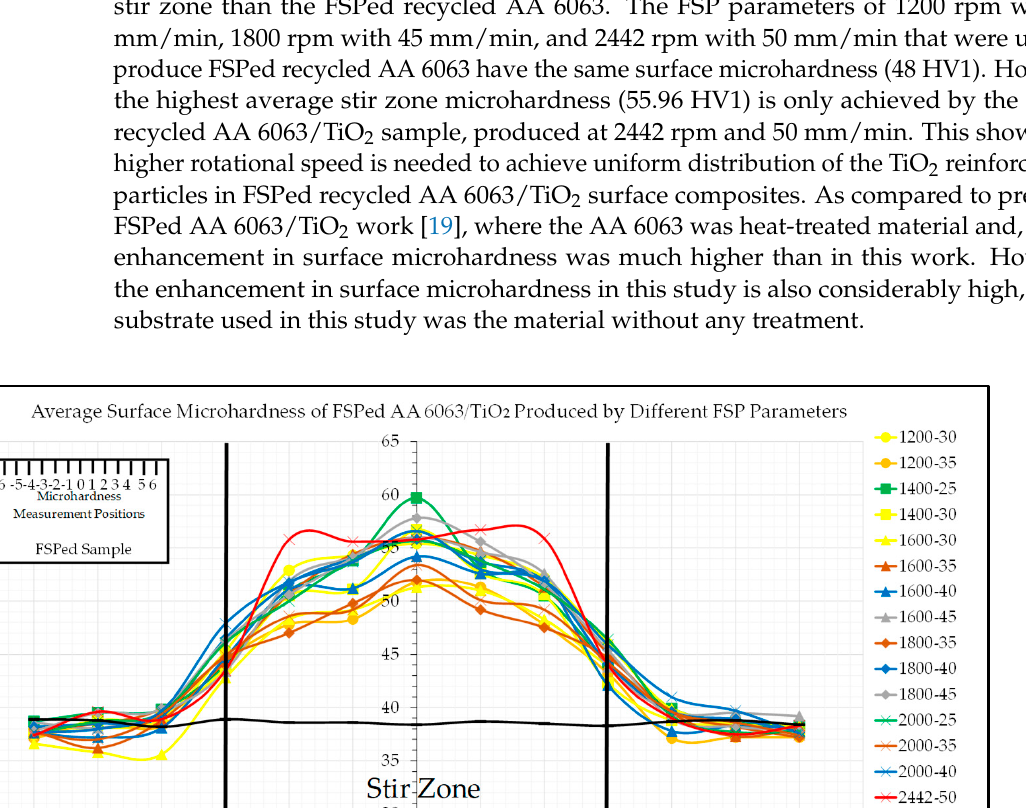
Figure 14. Stir zone microhardness of FSPed recycled AA 6063/TiO 2 vs. FSPed recycled AA 6063 and substrate material.